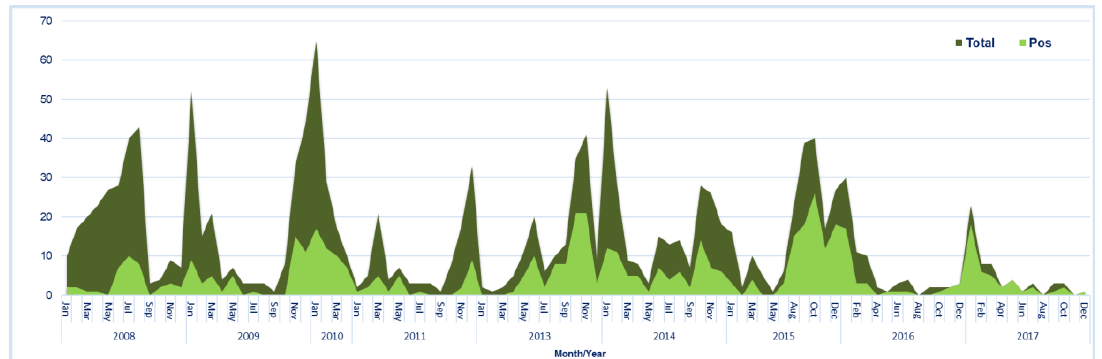
Figure 1. The stacked area chart represents, the total number of gastroenteritis (GE) cases tested and the number of GE cases testing norovirus-positive cases per month/year. Filled deep green area==total number of GE cases; Filled light green area==number of norovirus positive cases.